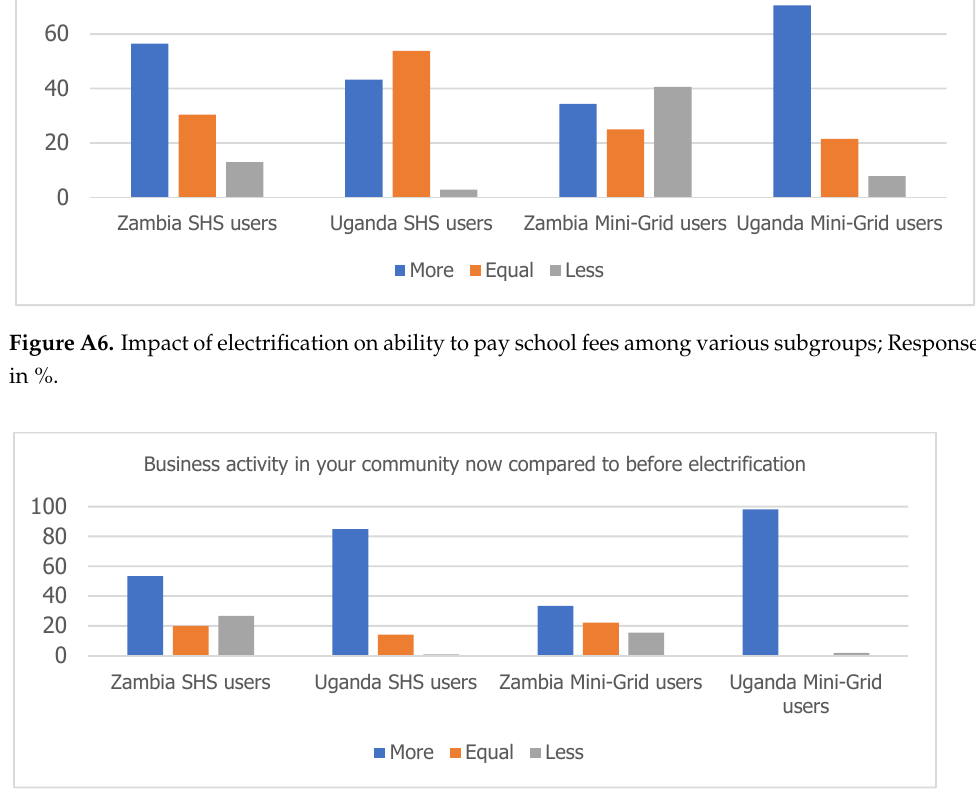
Figure A8. Impact of electrification on education among various subgroups; Responses in %. Figure A9. Perceived negative effects of electrification among various subgroups; Responses in %. Appendix B. Additional Information: Optimisation Approach & Background—60 kWp and 45 kWp Solar Energy Mini-Grid for a Location like Mpanta Appendix B.1. Estimating PV Power Output The estimation of solar PV output power in Mpanta, Zambia is calculated through the World Bank Solargis map for Zambia [71]. This map provides a summary of the esti- mated solar PV power generation potential. It represents the average daily and yearly sum of electricity production from a 1 kWp grid-connected solar PV power plant calcu- lated for the recent 24-year period 1994–2017. The PV system configuration consists of